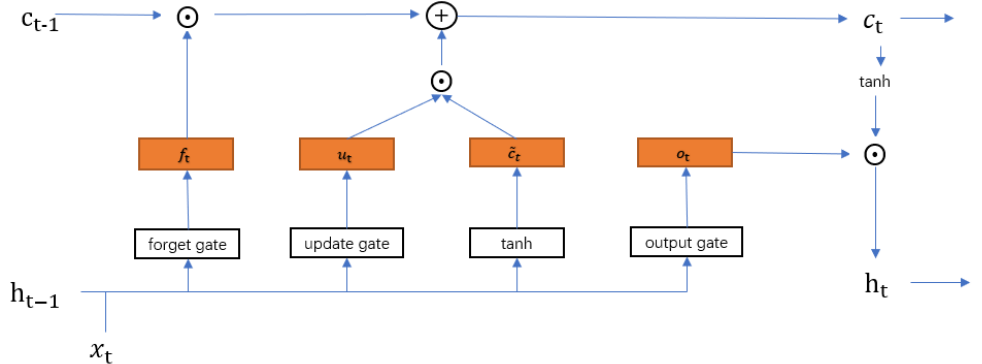
Figure 4. LSTM unit structure. The output of the update gate ( ) calculate the new status information ( )